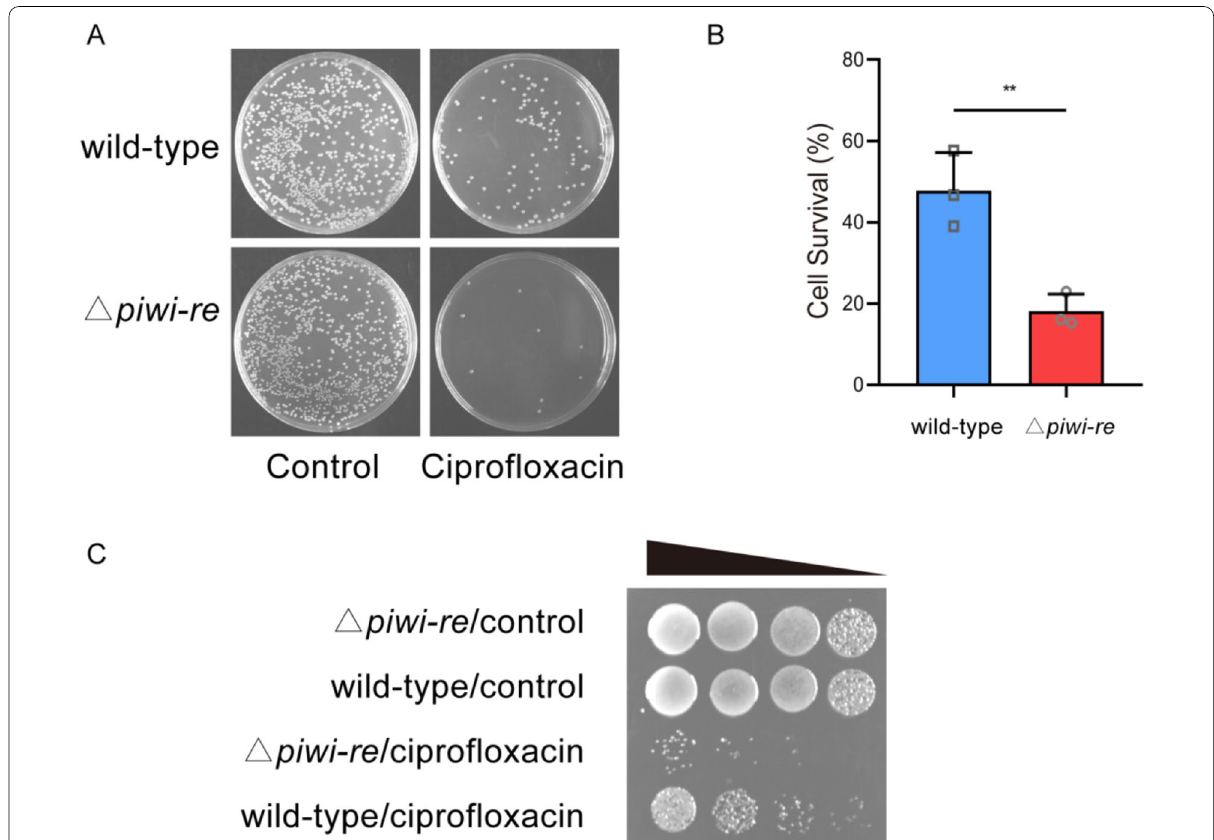
Fig. 4 Effects of ciprofloxacin on the survival rates of wild-type and △ piwi-re strains of P. stutzeri . A Growth status of wild-type and △ piwi-re strains after ciprofloxacin treatment. The control group was not treated with ciprofloxacin. B Survival rate of wild-type and △ piwi-re strains after ciprofloxacin treatment. Mean values SD are shown ( n 3, ** p 0.0016). The p value was calculated using an unpaired Student’s t -test. C Effect on ± = = growth state of wild-type and △ piwi-re strains after treatment with ciprofloxacin and serial